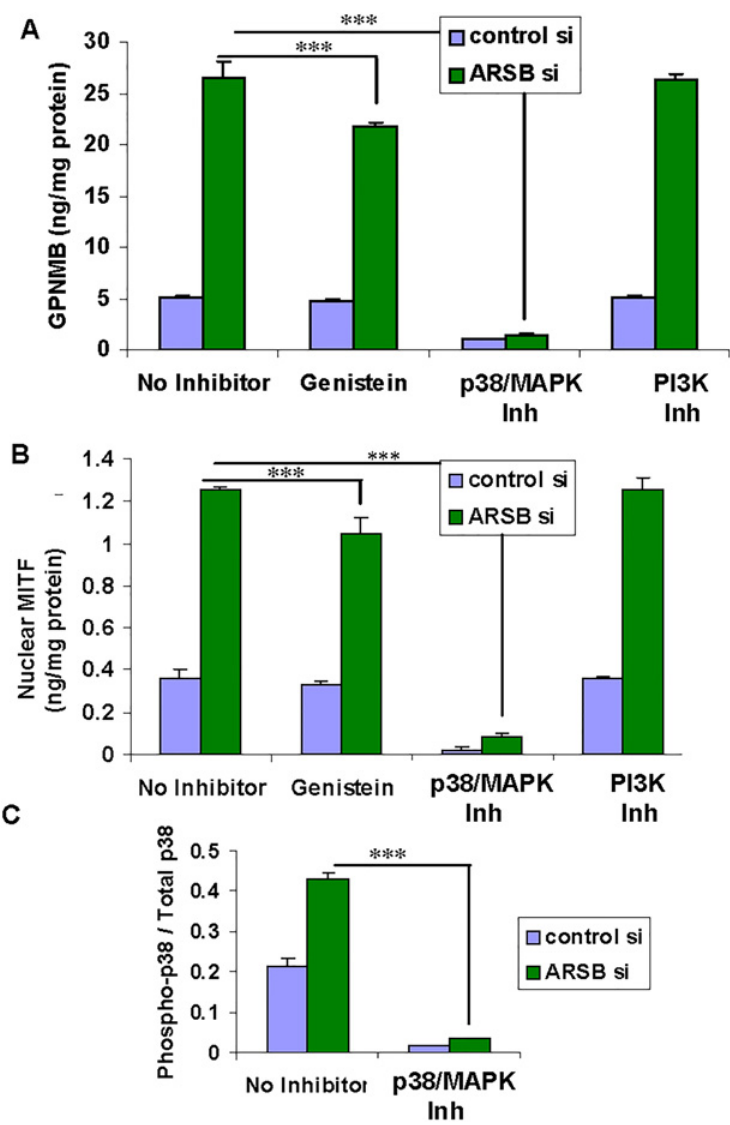
Fig 3. Phospho-p38 inhibitor blocks increases in GPNMB and nuclear MITF. (A) When HepG2 cells were treated with the phospho-p38 MAPK inhibitor SB20350, the ARSB siRNA- induced increase in GPNMB declined from 26.4 ± 1.7 ng/mg protein to 1.4 ± 0.2 ng/mg protein (p < 0.001, n = 3). Baseline GPNMB declined > 80% (from 5.1 ± 0.2 ng/mg protein to 1.0 ± 0.04 ng/mg protein) following exposure to SB20350. Genistein also significantly reduced GPNMB, to 21.7 ± 0.4 ng/mg protein (p < 0.001, n = 3), but the PI3K/AKT inhibitor (LY294002) had no effect. (B) The increase in nuclear MITF induced by ARSB siRNA was inhibited by SB20350, declining from 1.25 ± 0.02 ng/mg protein to 0.084 ± 0.015 ng/mg protein (p < 0.001; n = 3). Genistein also significantly inhibited the ARSB siRNA-induced increase (to 1.04 ± 0.07 ng/mg protein; p < 0.001; n = 3), but LY294002 had no effect. (C) The phospho-p38 MAPK to total p38 ratio was determined by fast-activated cell-based ELISA. The ratio more than doubled following ARSB silencing (from 0.21 ± 0.02 to 0.43 ± 0.02), and declined significantly following exposure to SB20350 (to 0.015 ± 0.002 with control siRNA and to 0.032 ± 0.003 with ARSB siRNA), demonstrating the effectiveness of the inhibitor. [ARSB = arylsulfatase B; GPNMB = glycoprotein (transmembrane) NMB; MITF = microphthalmia-associated transcription factor; si =